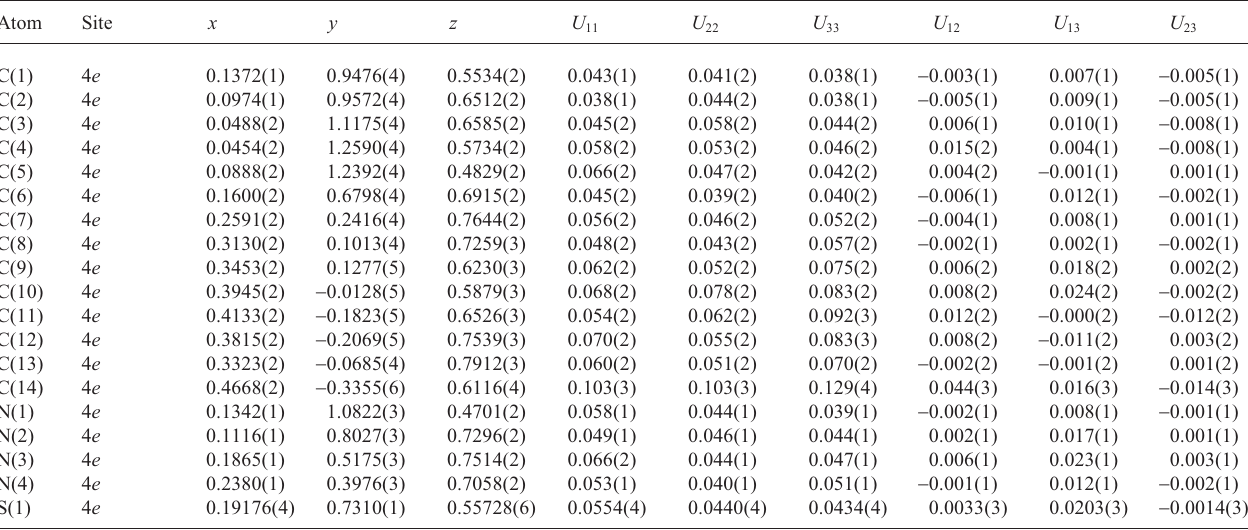
Table 3. Atomic coordinates and displacement parameters (in Å 2 )